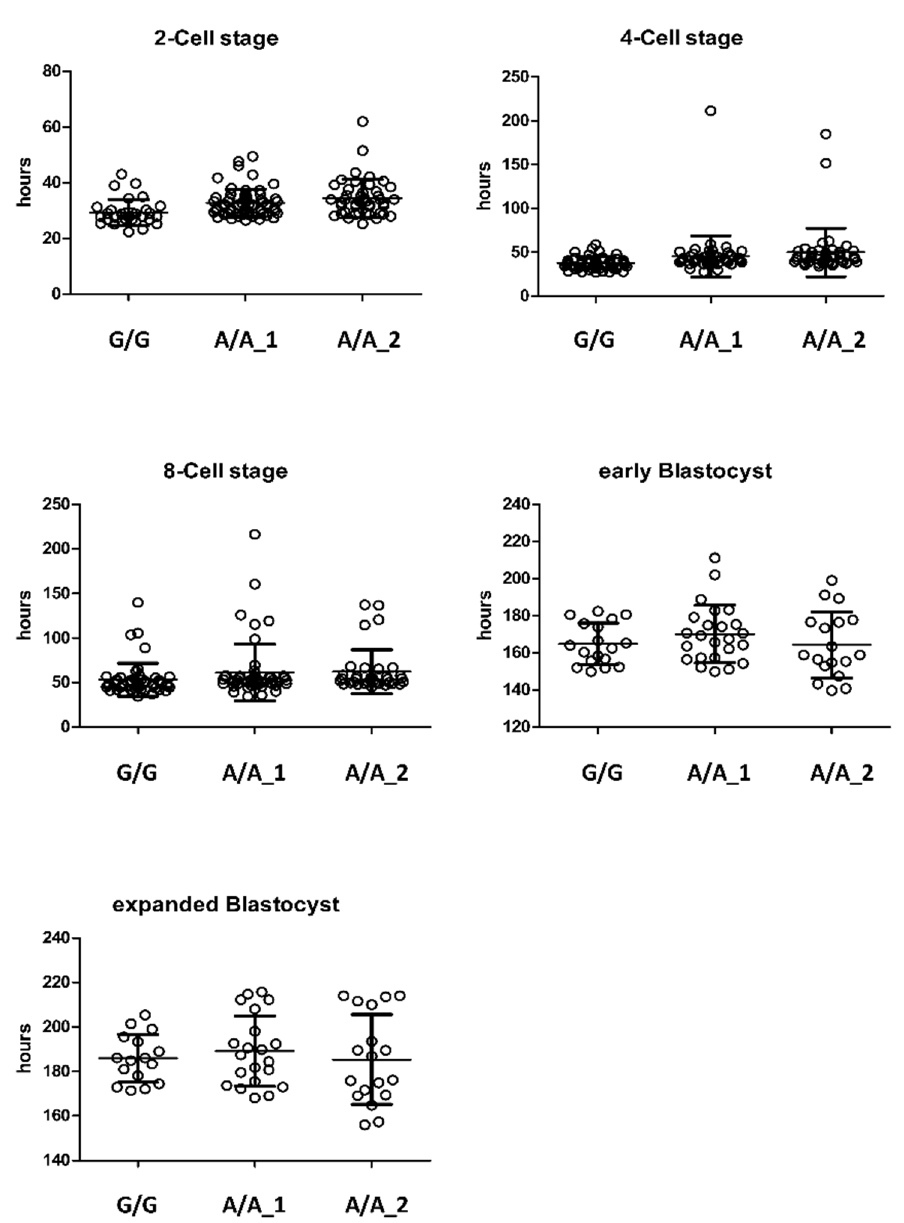
Figure 2. Effect of bull genotype on early embryo development. Data are presented with hours for early embryos to reach distinct stages after fertilizing in vitro generated with sperms from one wild-type and two homozygous carriers.